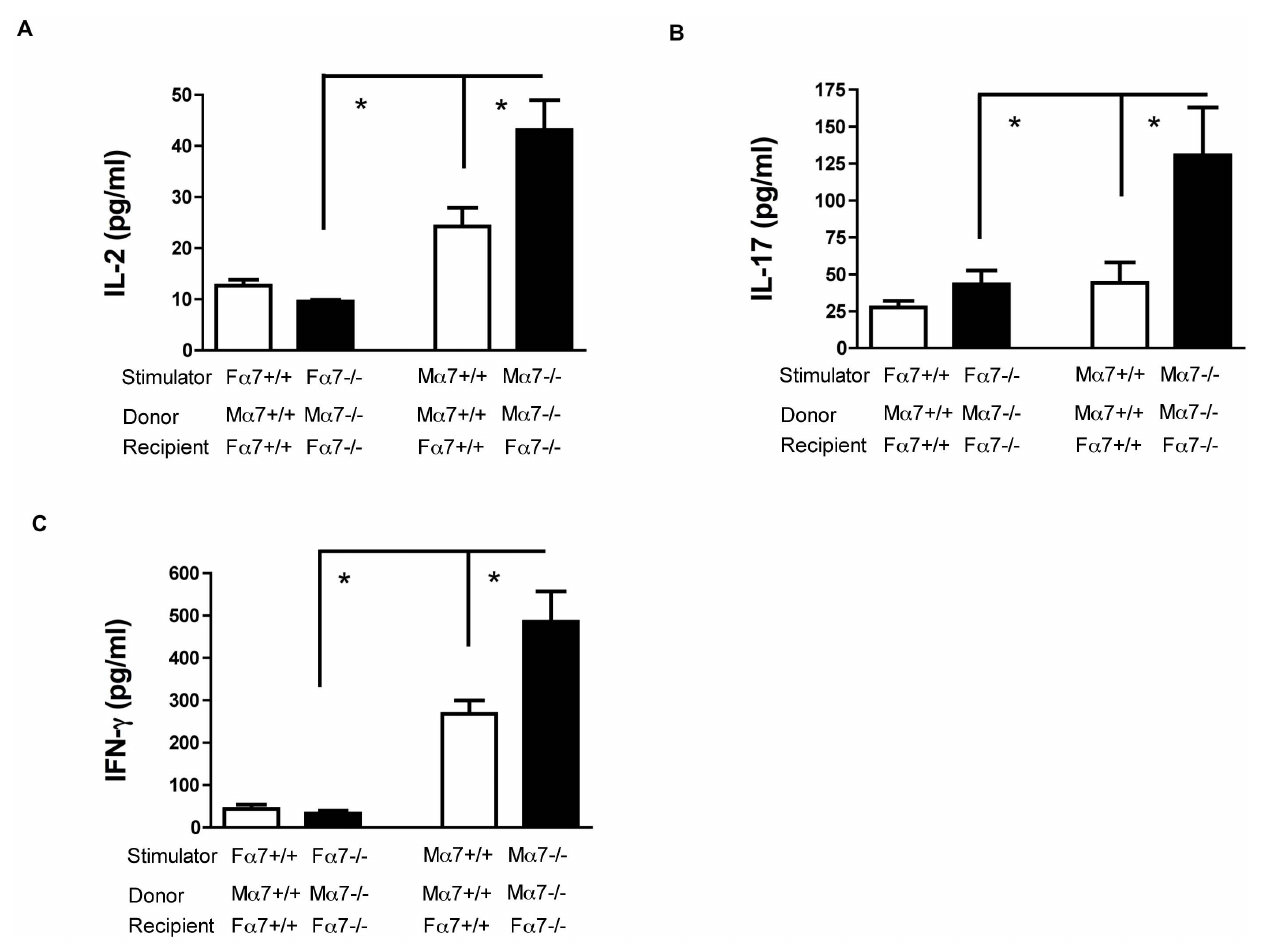
Figure 3. Anti-donor T cell responses are regulated through the cholinergic anti-inflammatory pathway. ( A to C ): Splenocytes harvested from either a 7 + / + (white bars) or a 7 2 / 2 (black bars) male to female donor-recipient combinations were stimulated in mixed lymphocyte reactions with a 7nAchR-matched female or male splenocytes. IL-2 ( A ), IL-17 ( B ) and IFN- c ( C ) production in the supernatants was quantified by ELISA. (F) indicates female and (M) indicates male. (*): p , 0.05 compared with wild type a 7 + / + donor-recipient combination or female stimulation.